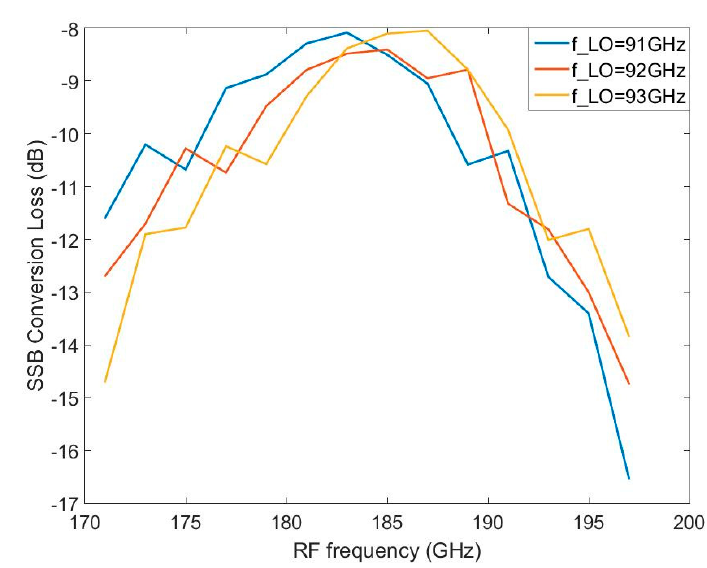
Figure 16. SSB conversion loss at different LO frequency of the 183 GHz mixer.